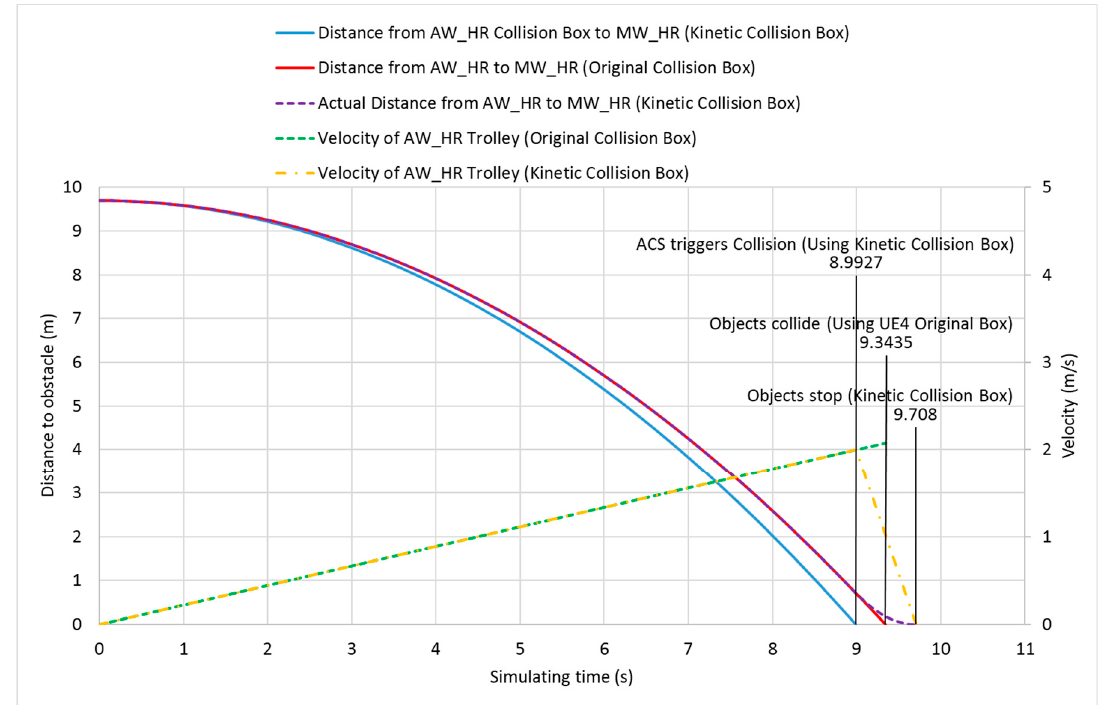
Figure 14. Functionality of the kinematic collision box algorithm in Scenario 2.